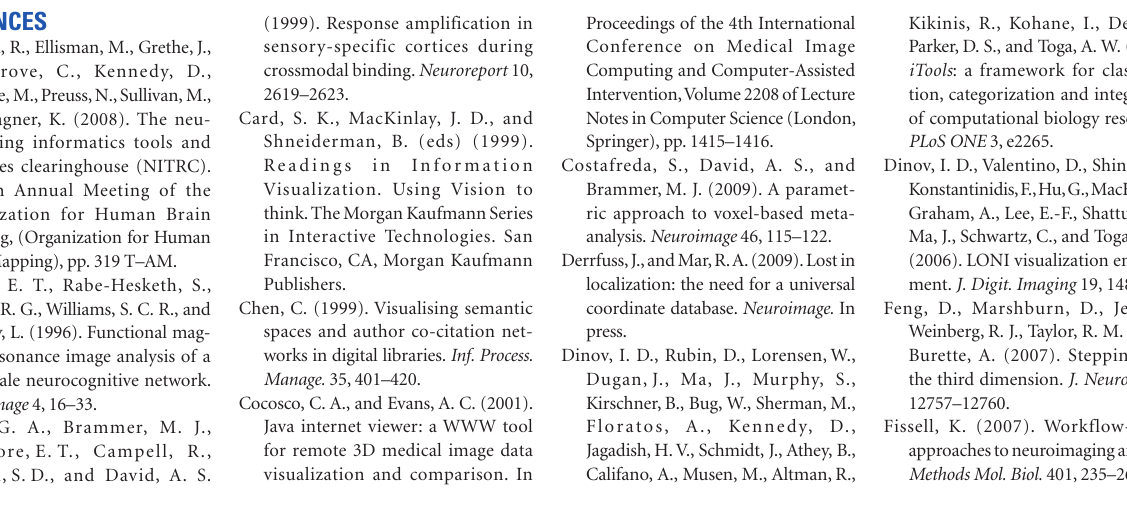
more effort, and in the Brede Wiki only simple visualizations are presently available. A target for future development should be towards ‘Science 2.0’ where data, analyses and visualizations can be shared in Web-based collaborative and user-friendly